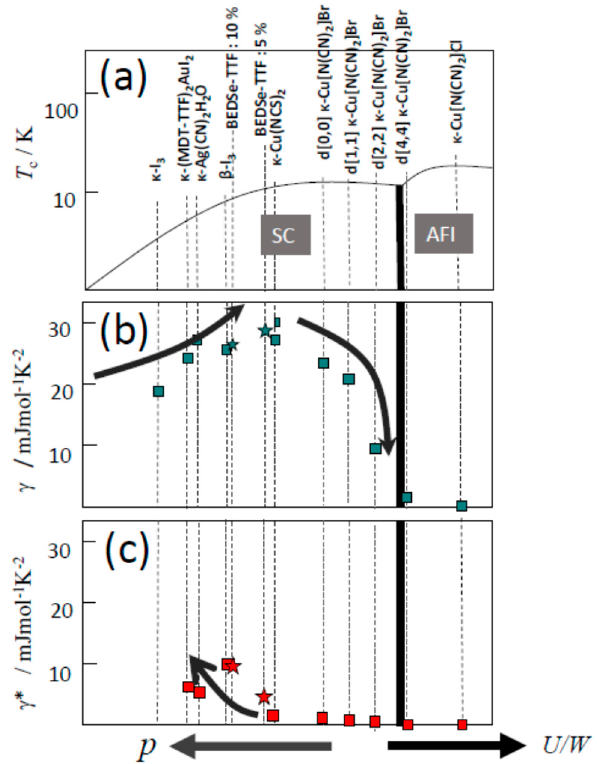
Figure 10. Systematic variations of the low-temperature thermodynamic parameters in the compounds mapped in the dimer-Mott phase diagram ( a ). Changes in ( b ) the normal states electronic heat capacity coefficient γ obtained by heat capacity data above H c2 and ( c ) the residual electronic heat capacity coefficient γ * in the superconductive state at 0 T are plotted in accordance with the position in the phase diagram. The position of each compound is determined in reference to Refs [11,14,15]. The data are taken from Table 9 in Ref. [28] and the reported results data in Refs [42,59–63]. Systematic change of the thermodynamic parameters occurring with the change in chemical pressure, namely the change in the parameter of the U/W ratio, suggests that a kind of crossover exists inside the superconductive phase. Compounds shown as the name of the counter-anions are BEDT-TTF(ET) complexes. BEDSe-TTF 5%, 10% mean the solid solution systems of BEDT-TTF and BEDSe-TTF. (See text.) d[ n , n ]-Cu[N(CN) 2 ]Br denotes a Cu[N(CN) 2 ]Br compound with BEDT-TTF of which ethylene groups are partially deuterated (Ref. [61,62]) to tune the chemical pressure. Arrows show the characteristic tendency reflecting the physical properties.